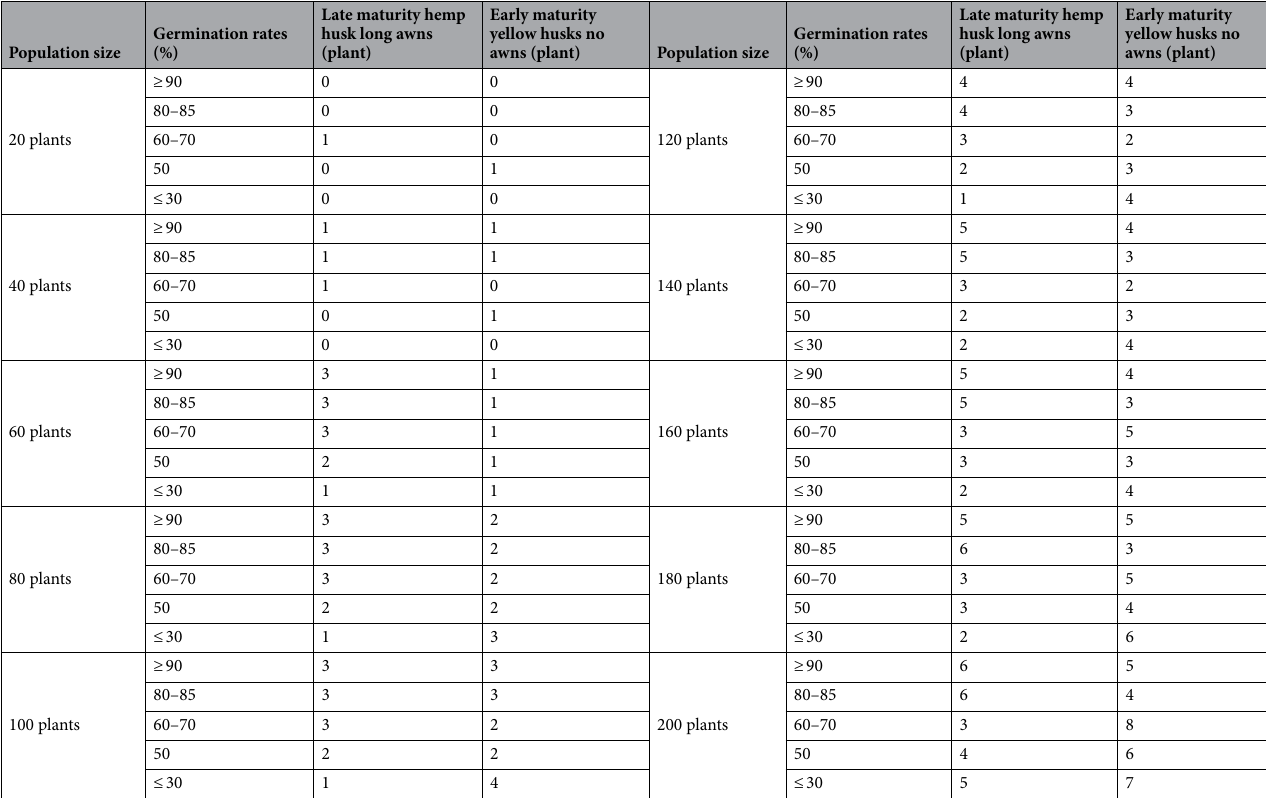
Table 3. Population size for reproduction of Xianggu on the genetic diversity of phenotypic traits with different germination rates.